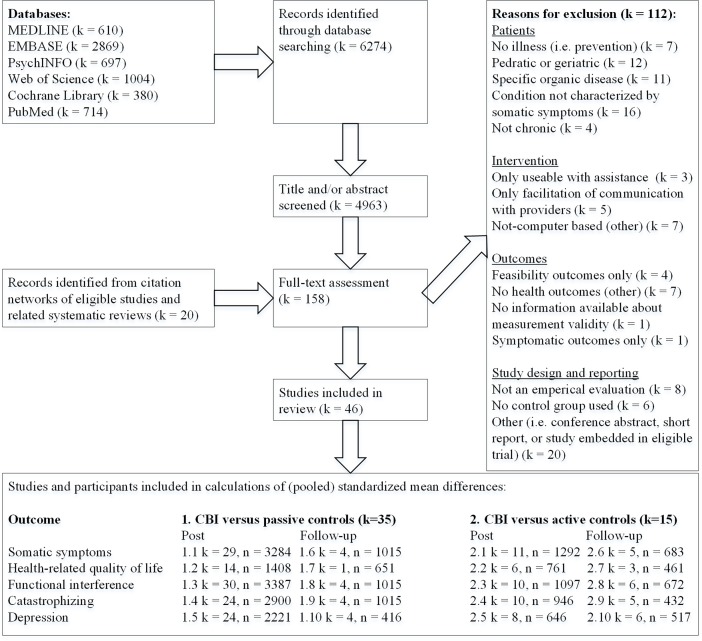
PRISMA flow-diagram of studies.Abbreviations and symbols: k = number of studies, n = number of study participants, OC = outcome, SS = Somatic Symptoms, HRQOL = Health Related Quality Of Life, FI = Functional Interference, CAT = Catastrophizing, DEP = Depression.